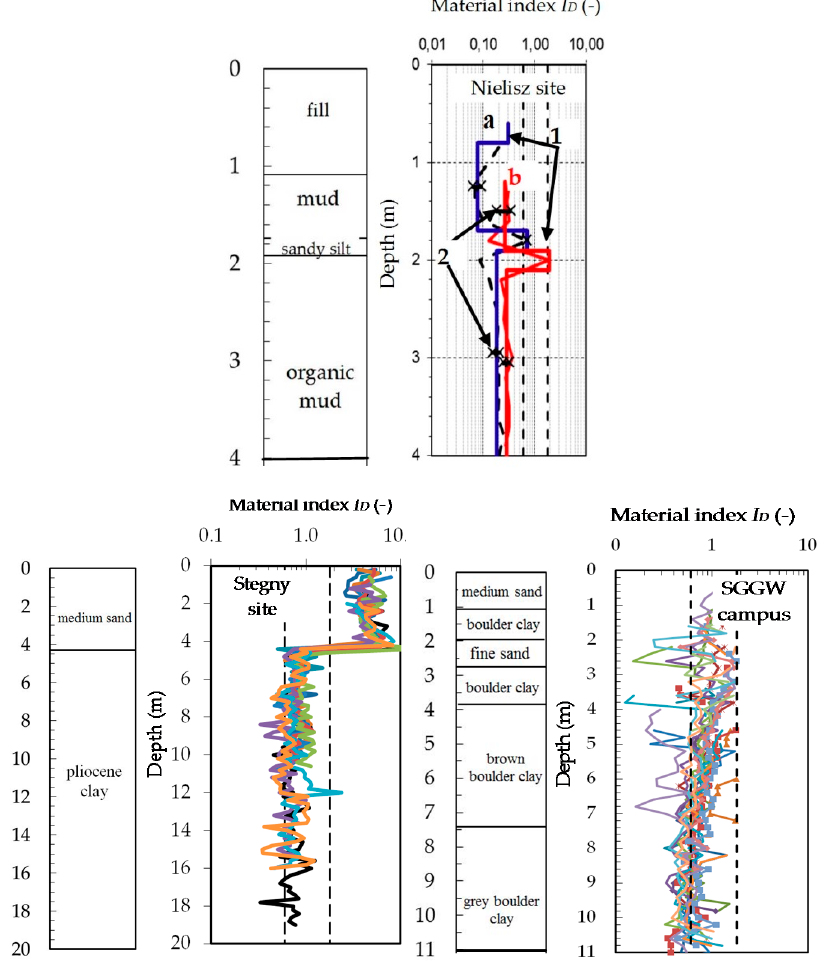
Figure 8. Profiles of material indexes I D from the DMT tests carried out for the subsoil of the Nielisz, Stegny and the SGGW Campus sites: ( a )—before loading, ( b )—after loading for Nielisz site; 1—measured values, 2—average values ± one standard deviation.